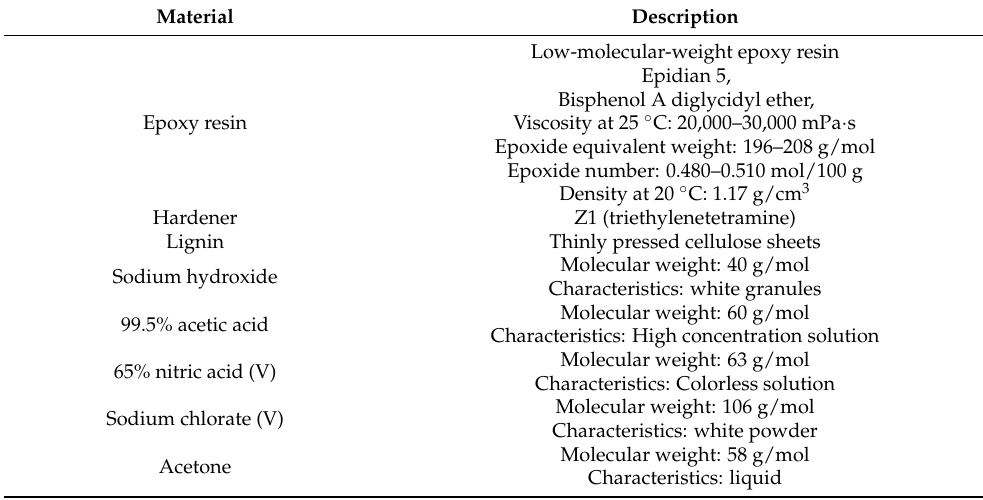
Table 1. Materials used for